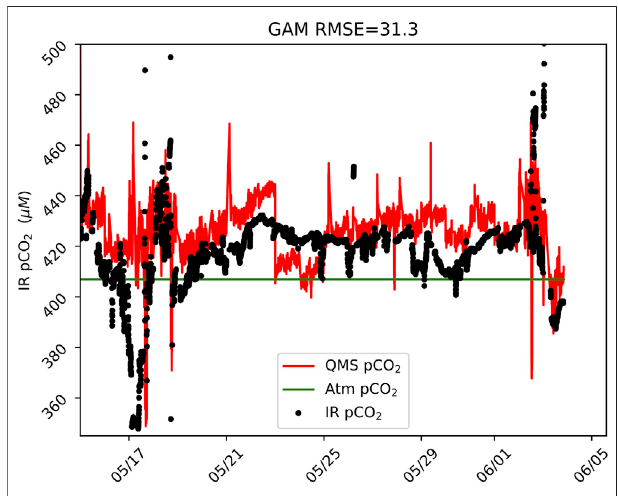
FIGURE 11 | Bias-corrected and calibrated pCO 2 from shipboard QMS alongside measurements of pCO 2 by infrared absorption spectroscopy (IR pCO 2 ) in the Ross Sea,